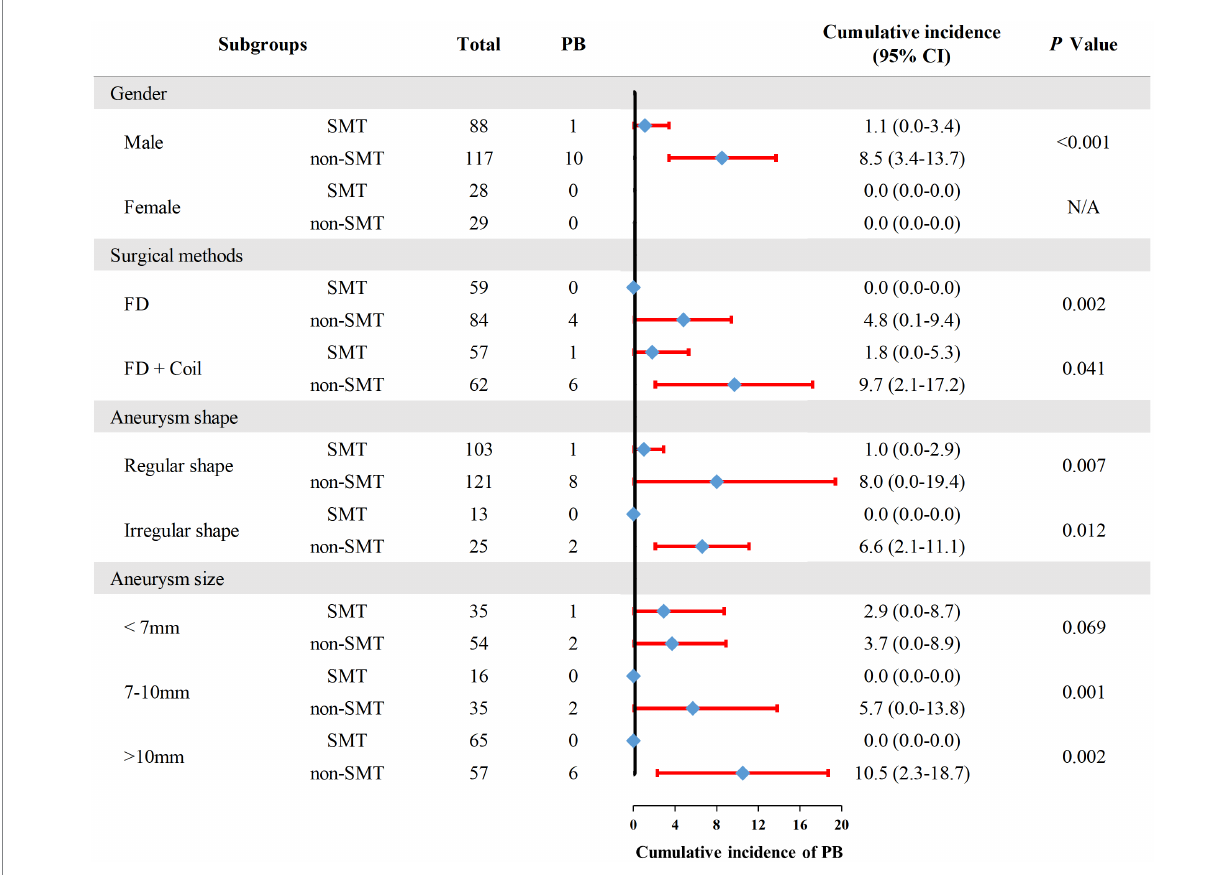
FIGURE 4 The incidence of postoperative bleeding in each subgroup. PB, postoperative bleeding; SMT, standard methylprednisolone treatment; FD, flow